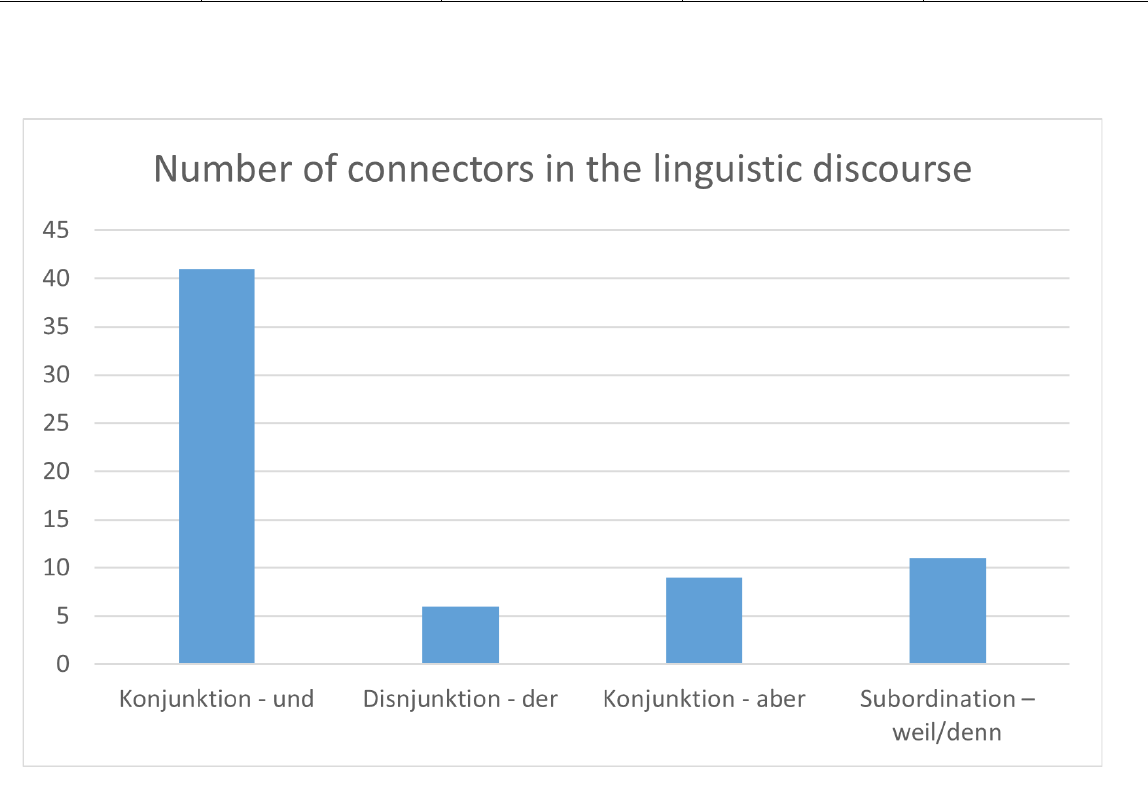
Figure 1 - The detection of connectors in the linguistic discourse of Süddeutsche Zeitung magazine, publications of November - December of years 2011 -